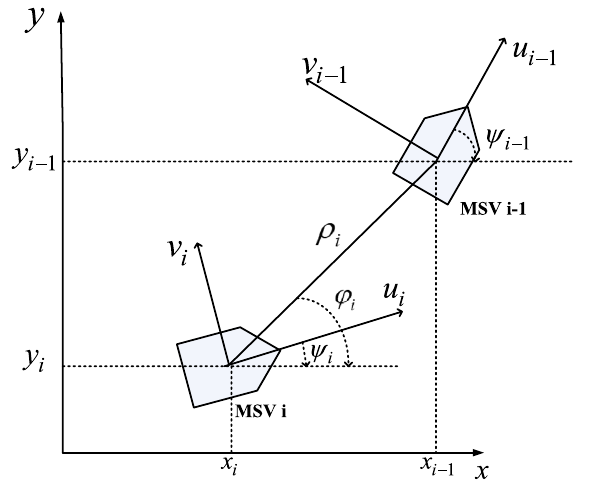
Figure 1. MSVs formation